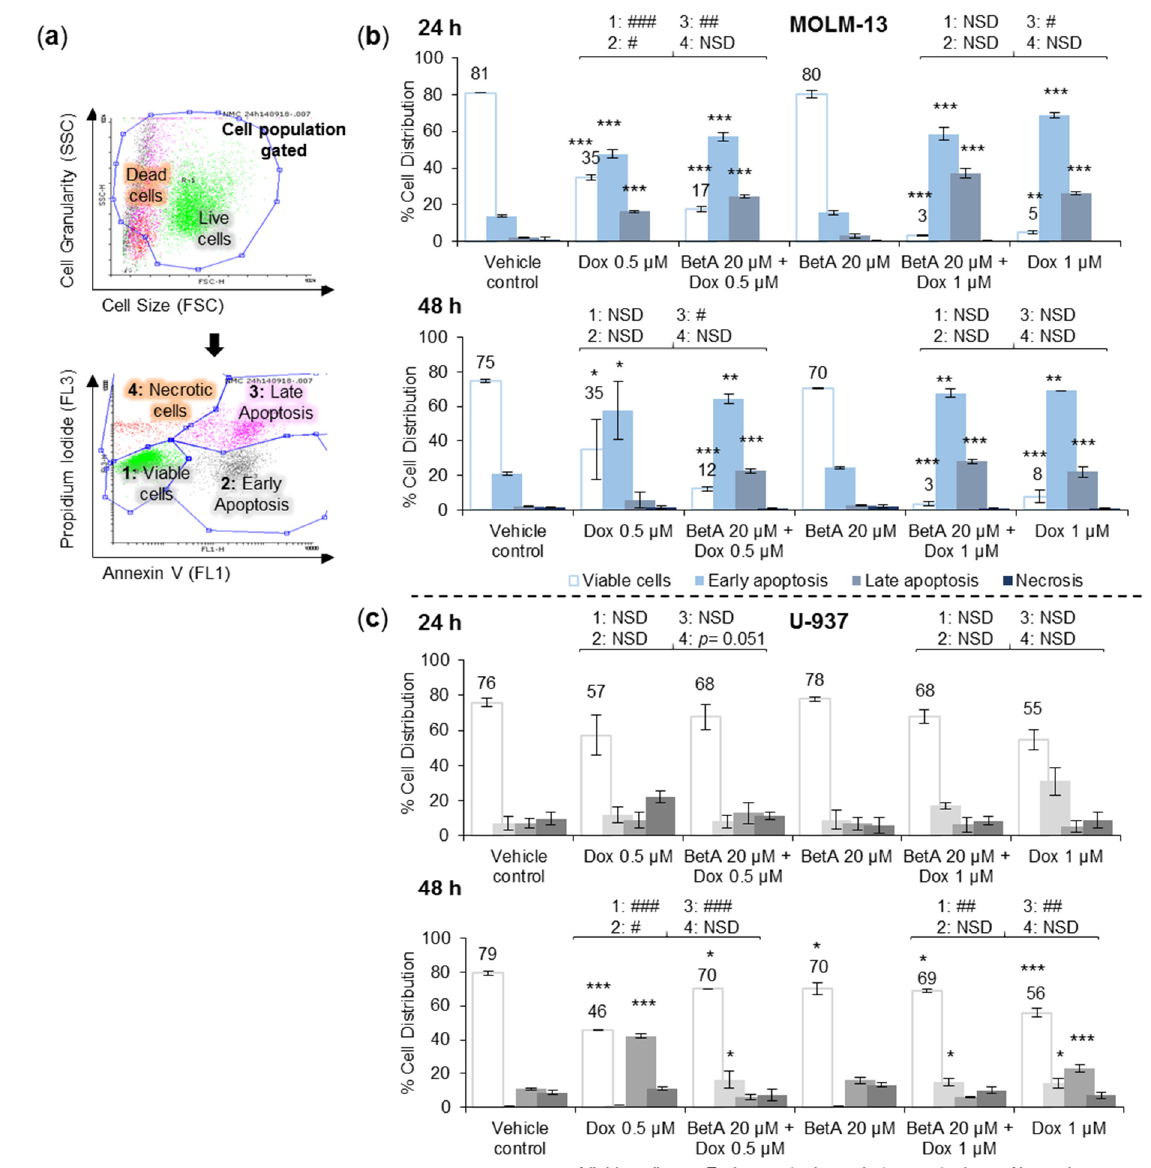
Figure 2. Cell death population of MOLM-13 and U-937 treated by individual drugs and combined therapy for 24 and 48 h. Samples were double stained by Annexin V (apoptotic cell dye) and Propidium Iodide (PI, dead cell dye). Gating of